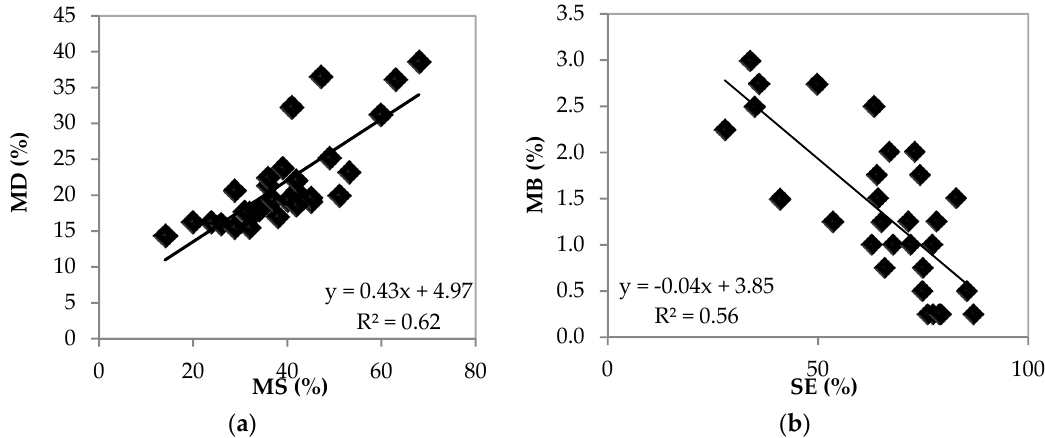
Figure 5. ( a ) Correlation between Micro-Deval (MD) and magnesium sulphate soundness coefficient (MS); ( b ) correlation between sand equivalent (SE) and methylene blue (MB).